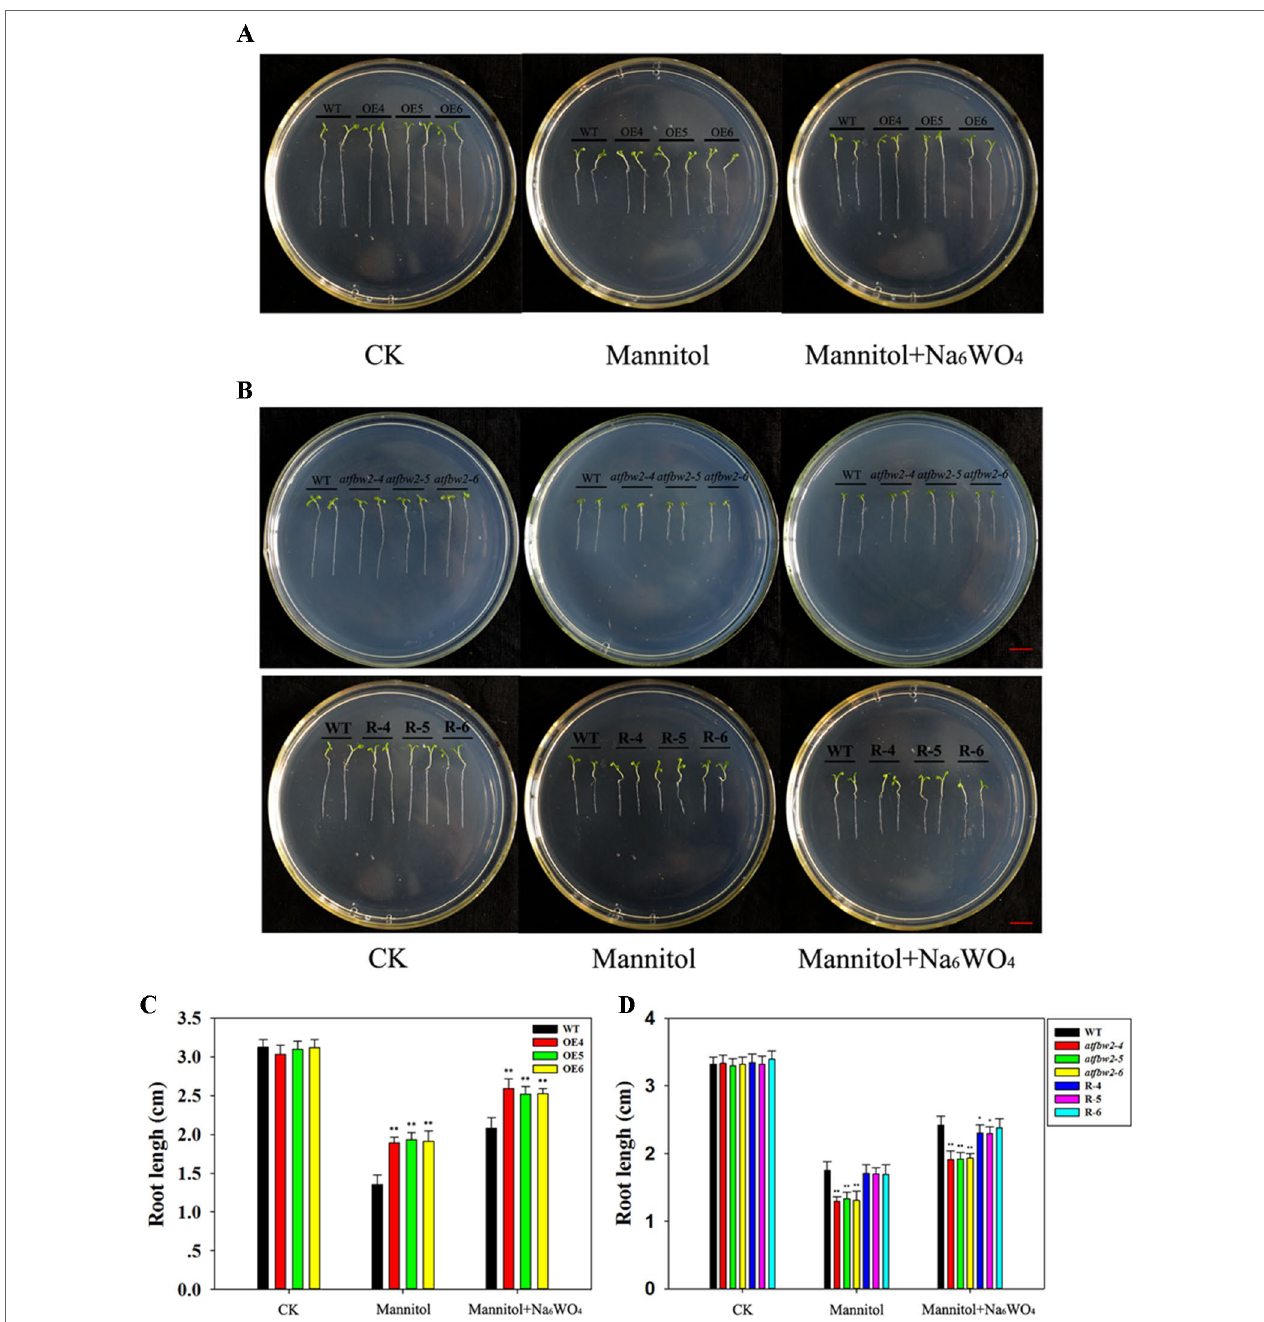
FIGURE 3 | Root growth of Arabidopsis plants under mannitol and mannitol + Na 6 WO 4 conditions. (A) Root growth phenotype and (C) root length statistics of WT and TaFBA1 overexpressing lines (OE4, OE5, OE6). (B) Root growth phenotype and (D) root length statistics of WT, mutant ( atfbw2-4 , atfbw2-5 , atfbw2-6 ), and recovery plants (R-4, R-5, R-6). Root lengths were measured 5 days following transfer of 3-day-old seedlings from MS medium to plates with or without mannitol and mannitol + Na 6 WO 4 . Data represent the mean ± SE of three biological replicates. * P < 0.05; ** P <